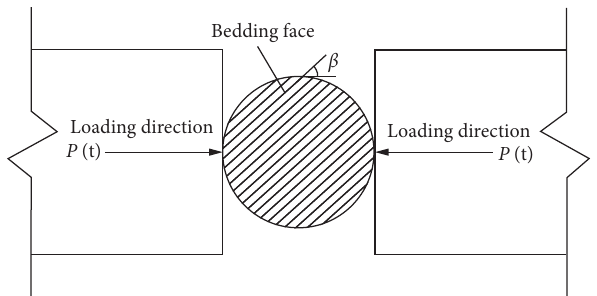
Figure 1: Loading method of layered slate for Brazilian splitting